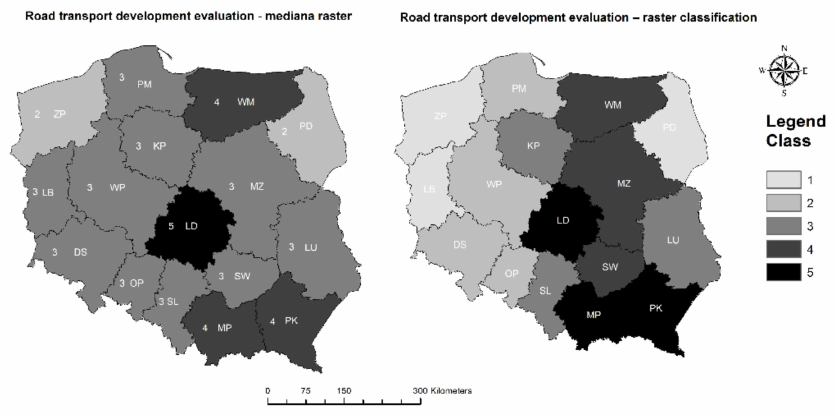
Figure 9. Comparison of results of the road transport development evaluation. Source: the